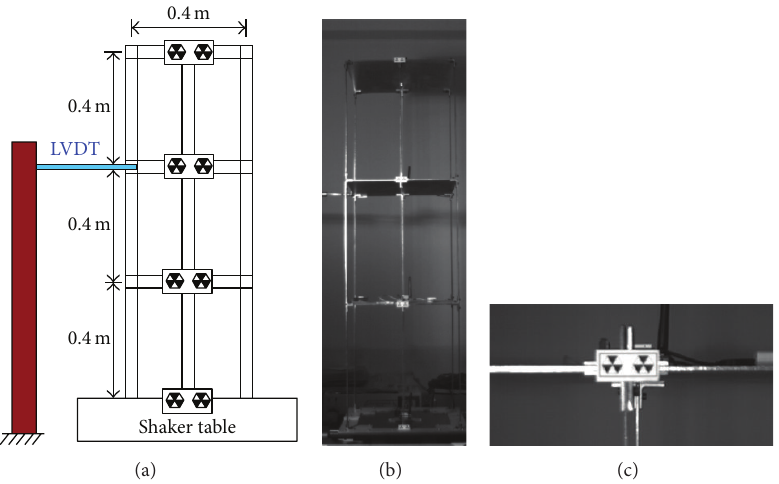
Figure 4: Configuration of small three-story frame and an LVDT on second floor (a). Image frame captured using measurement system with lower (b) and higher resolution (c).